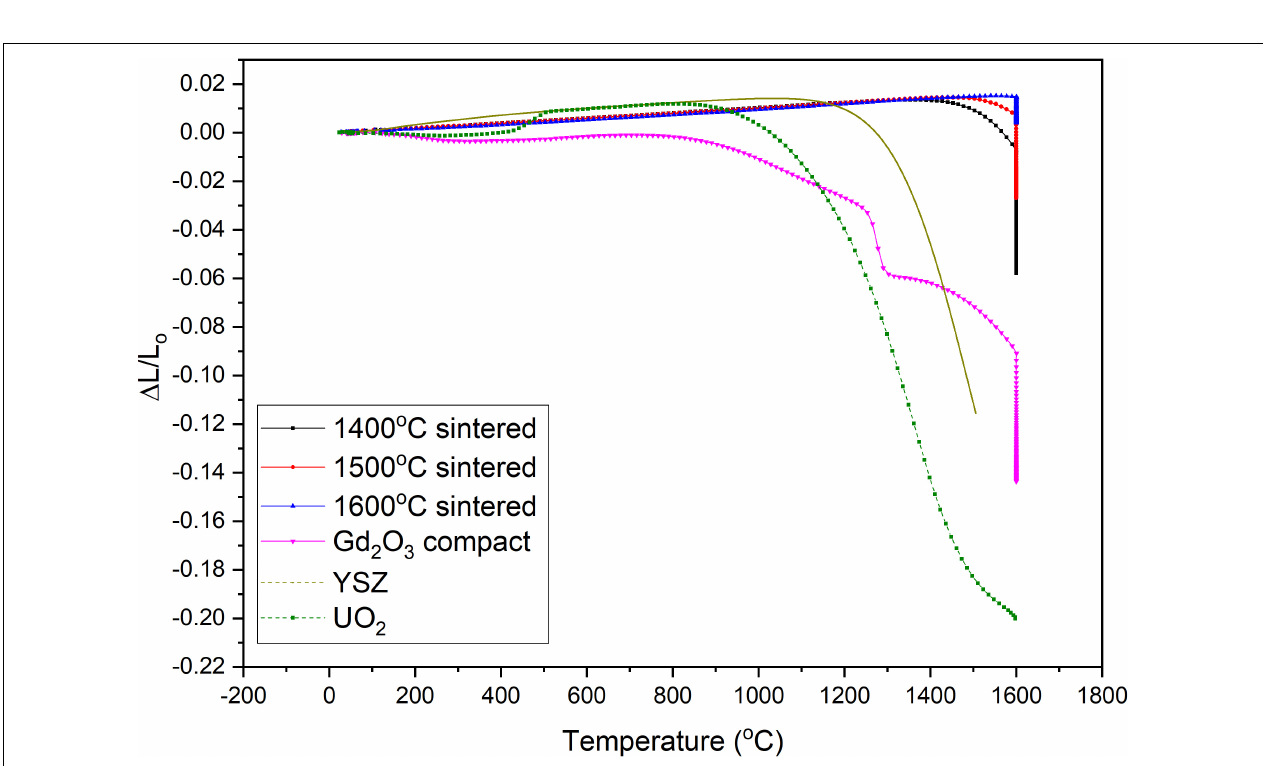
FIGURE 2 | Shrinkage behaviors of Gd 2 O 3 compact, sintered Gd 2 O 3 pellet, YSZ compact, and UO 2 compact.